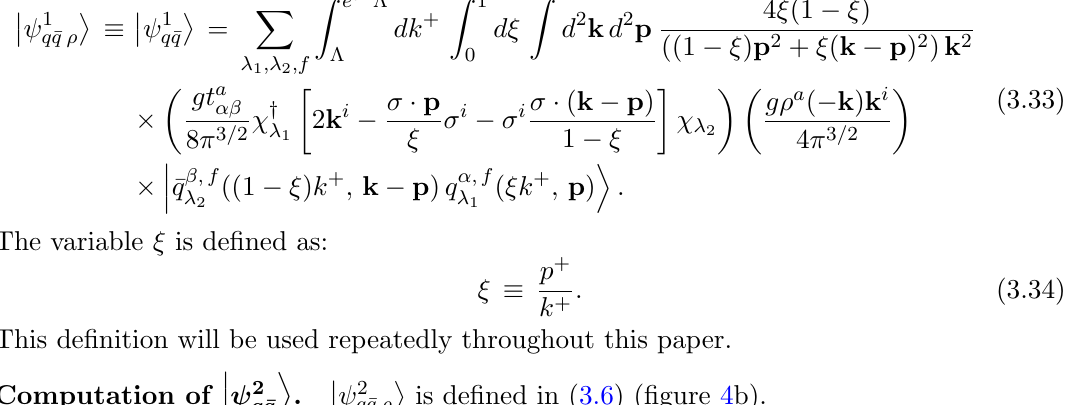
Figure 4 . Quark and anti-quark emission diagrams. The bold black line over the gluon in ( b ) marks the instantaneous interaction. ( a ) - After inserting the relevant matrix elements, (2.49) and (3.21), and integrating over q